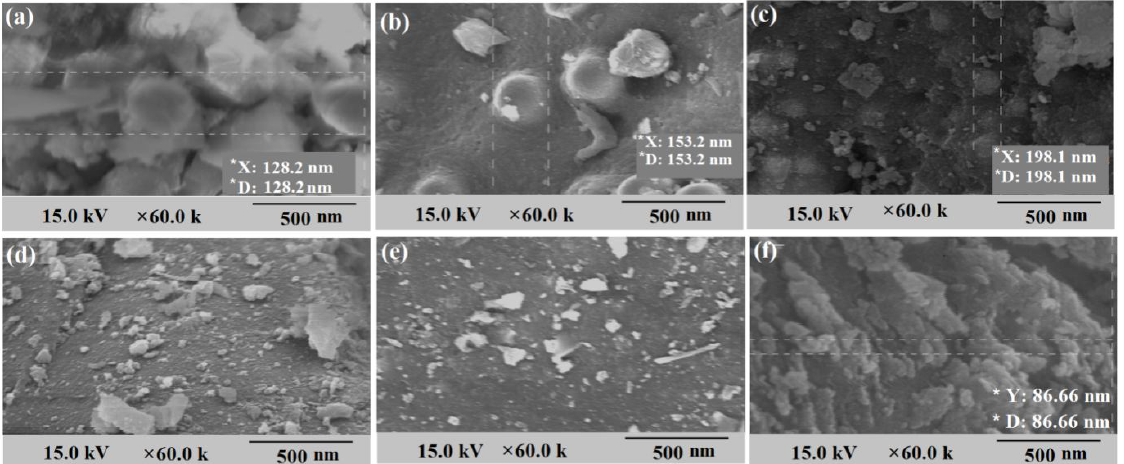
Fig.5. FE-SEM images of the powder samples with different TiO 200, (c) sample 300, (4) sample 400, (5) sample 500, (f) sample 600.